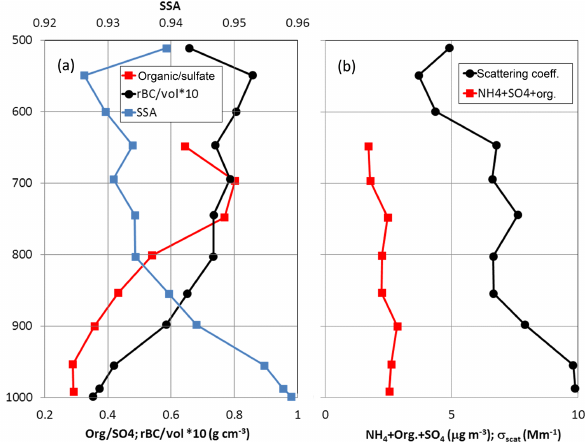
Figure 12. (a) Vertical profiles of the ratio of organic material to sulfate (Organic/sulfate) from Willis et al. (2019), the ratio of refrac- tory black carbon (rBC) to the volume concentration of the submi- cron aerosol estimated from the measured size distribution (Schulz et al., 2019) and one estimate of the single scatter albedo (SSA; Leaitch et al., 2019). (b) Profiles of the sum of the mass concen- trations of ammonium (NH 4 ), organic material (Org.) and sulfate (SO 4 ) with the light scattering coefficient ( σ scat ). All values are medians over approximately 50hPa pressure intervals. Results are for flights conducted out of Alert and Eureka, and constrained to σ scat < 15Mm − 1 , which represents 98% of the observed σ scat